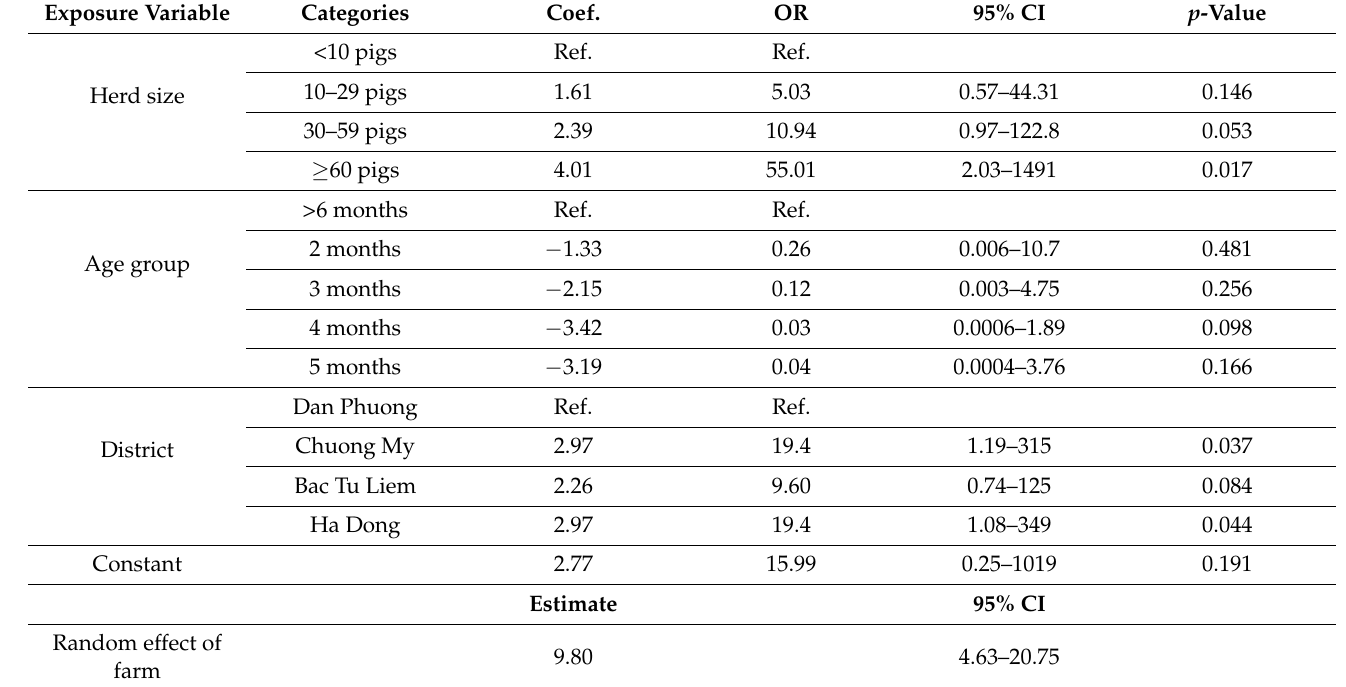
Table 10. Multivariable analysis of risk factors for